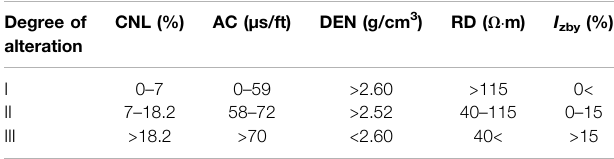
TABLE 2 | Classi fi cation criteria for the alteration degree of buried hill